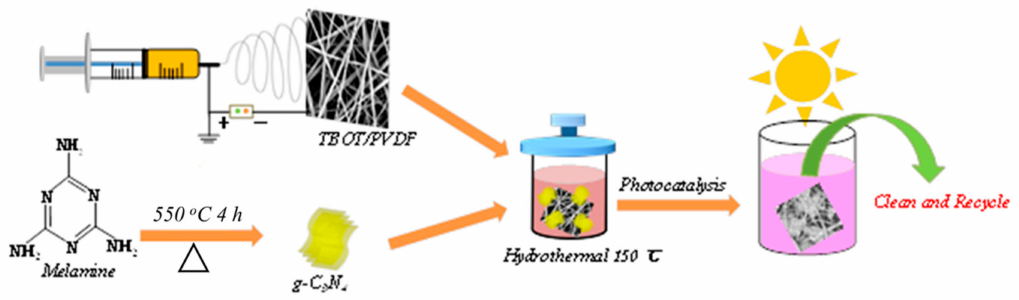
Figure 1. Schematic illustration of synthesis and photocatalytic application of the TPCN